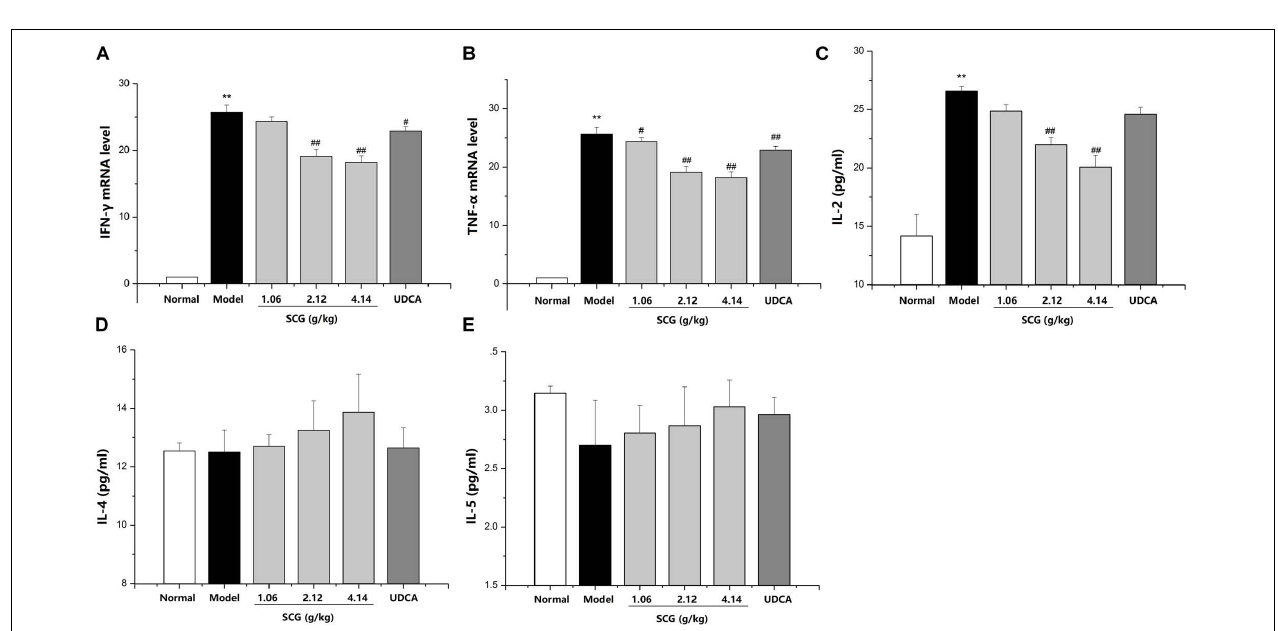
FIGURE 4 | Pharmacological effect of SCG on Con A-induced liver injury in mice. (A) The serum level of ALT. (B) The serum level of AST. (C) The activity of MPO. (D) HE-stained liver section for histopathology evaluations and the histological changes. Data were expressed as mean ± SD ( n = 6). ∗∗ P < 0.01 compared with normal group; # P < 0.05, ## P < 0.01 compared with model group.